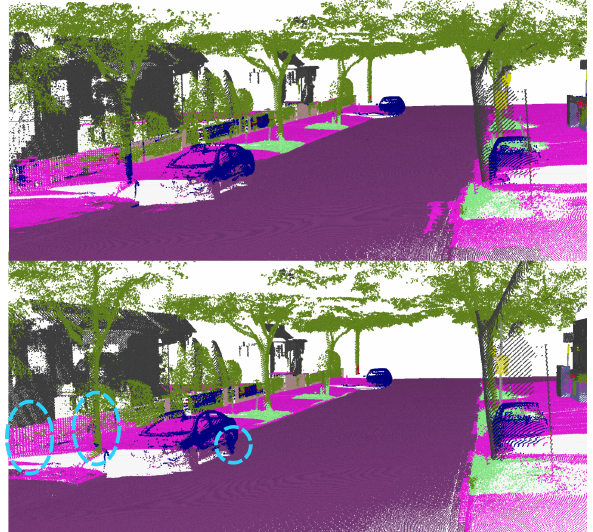
Figure 6. Visualization of the 3D labeled data. At the top we see the results of the projected semantic segmentation from the processing step (1). Bottom part shows the improved segmentation from the processing step (2). The color map: Blue - Car, Purple - Road, Pink - Sidewalk, Green - Vegetation, Light Green - Terrain, Yellow - Traffic Sign, Grey - (Wall, Pole, Fence), Light Blue - Accent Marker